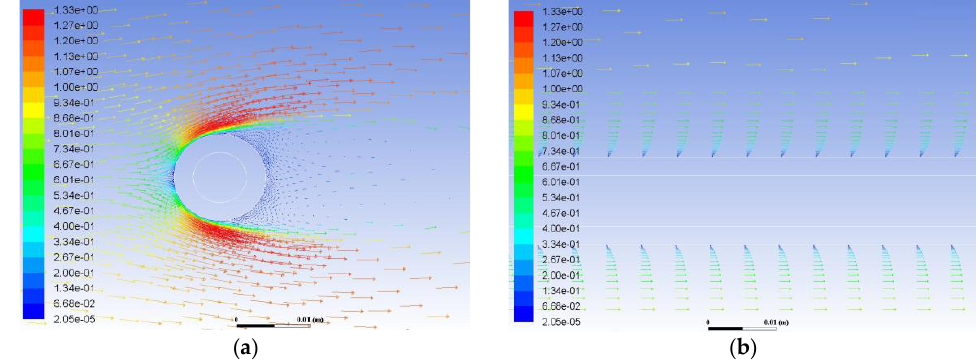
Figure 3. Air velocity vectors at a flow: ( a ) perpendicular to the power cable surface; ( b ) parallel to the power cable surface [30].